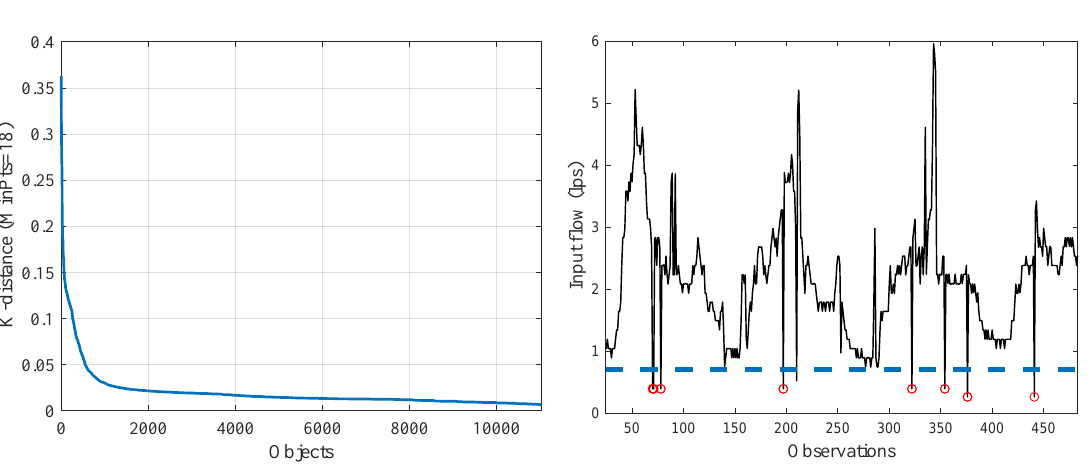
Figure 3. Partial results of the parameters and data of the DMA: ( a ) sorted objects vs. the Kproximity metric with a minimum cluster of 18 objects; ( b ) preprocessing flow rate considering the Minimum Night Flow (MNF) for a time window of